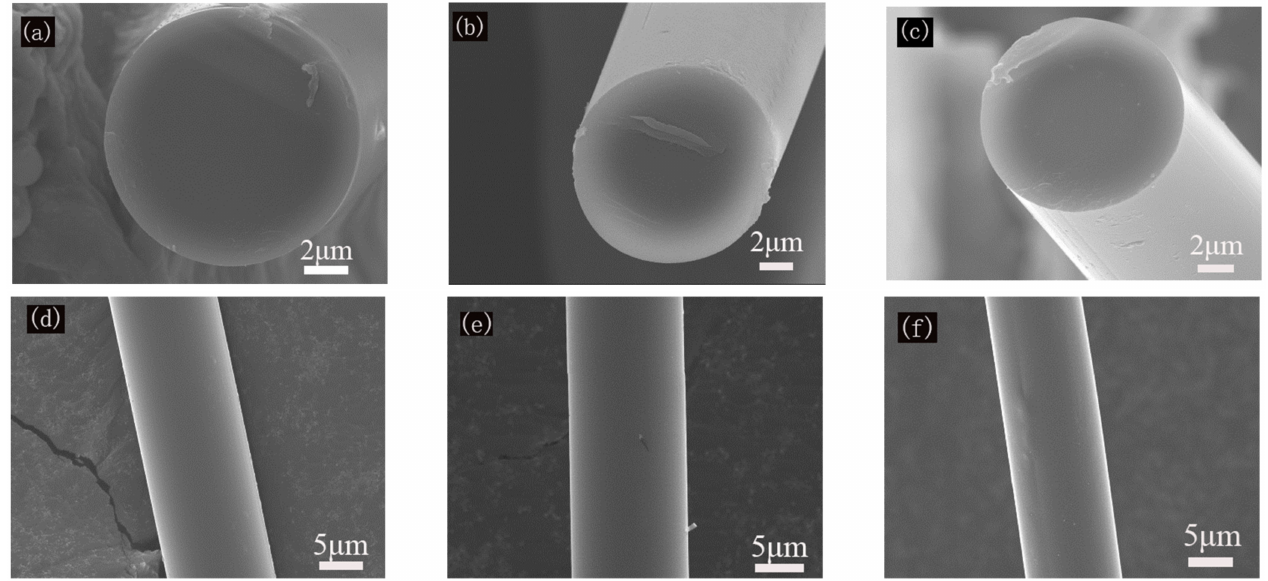
Figure 6. SEM images of the surface and cross sections of the composite fiber: ( a , d ) P1-F; ( b , e ) P2-F; ( c , f ) P3-F.